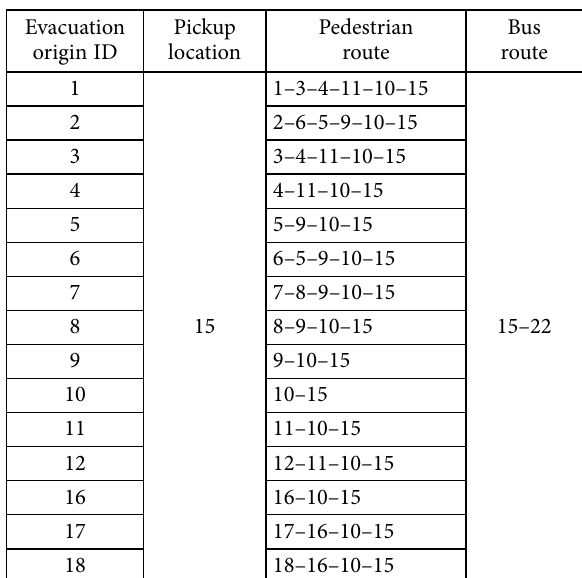
Figure 4. Results of random experiments: a – the evacuation duration time of random experiments; b – ranked evacuation duration time in descending order Table 4. Optimal results under Scenario 1